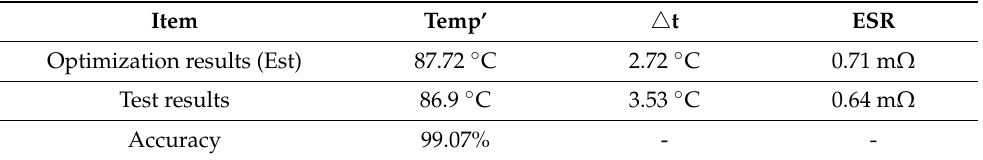
Table 9. Experimental results of optimization